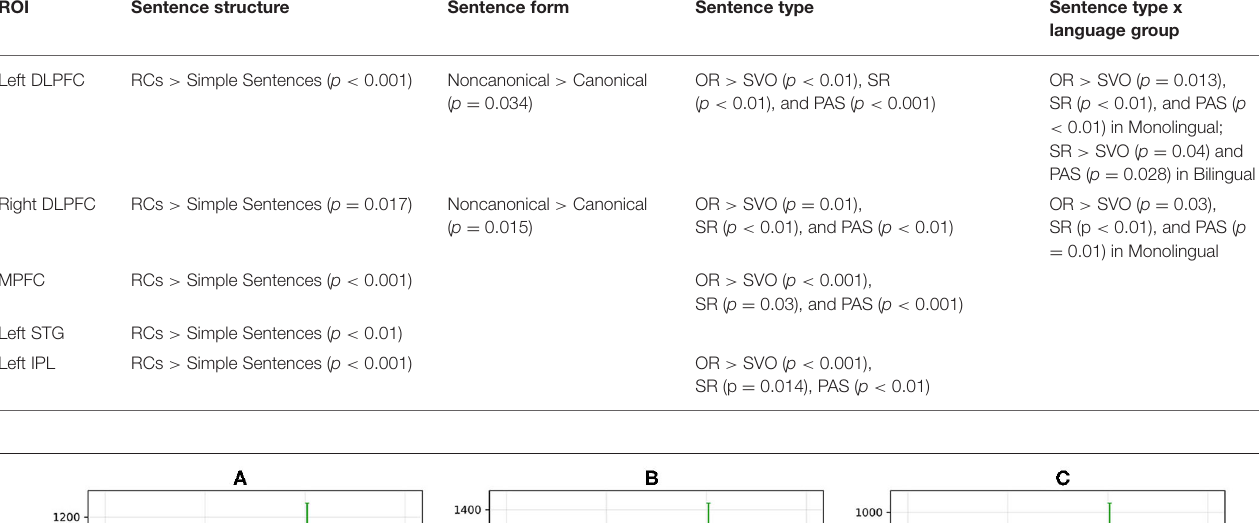
TABLE 5 | Main effects of sentence structure, sentence form, sentence type and sentence type x language group interaction across ROIs for monolingual and bilingual adults. ROI